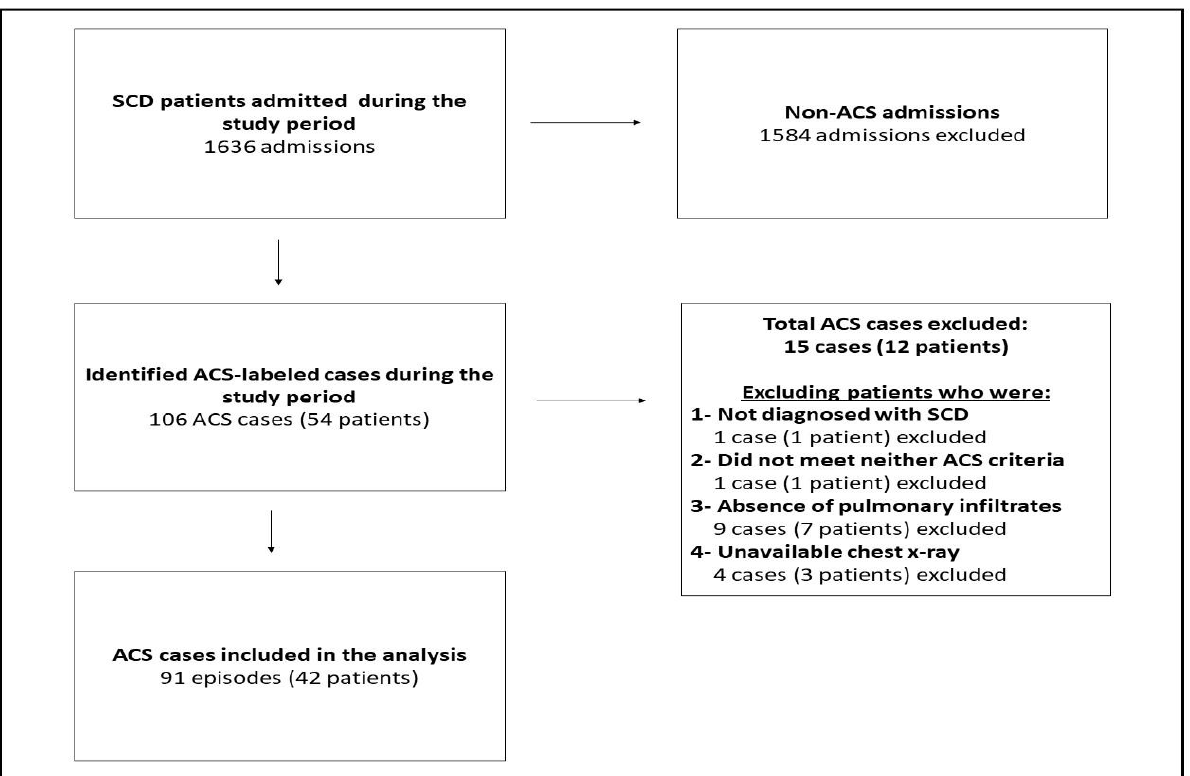
Figure 1. Flow chart showing the screening, inclusion, and exclusion processes. SCD, Sickle Cell Disease; ACS, Acute Chest Syndrome. Table 1. Demographics and baseline characteristics of the included patients [ n = 42].